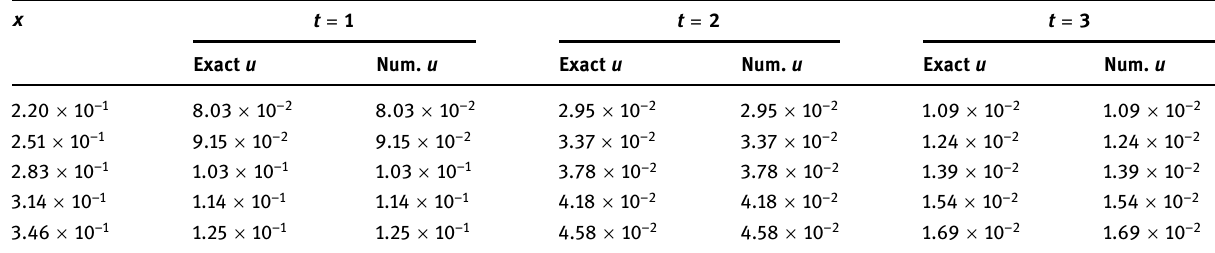
Table 5: Comparison of exact and numerical results of u at = t 1 , 2, and 3 for = N 101 , = α 10 , = β 5 , = t Δ 0.0001 , = τ 0.5 using Method